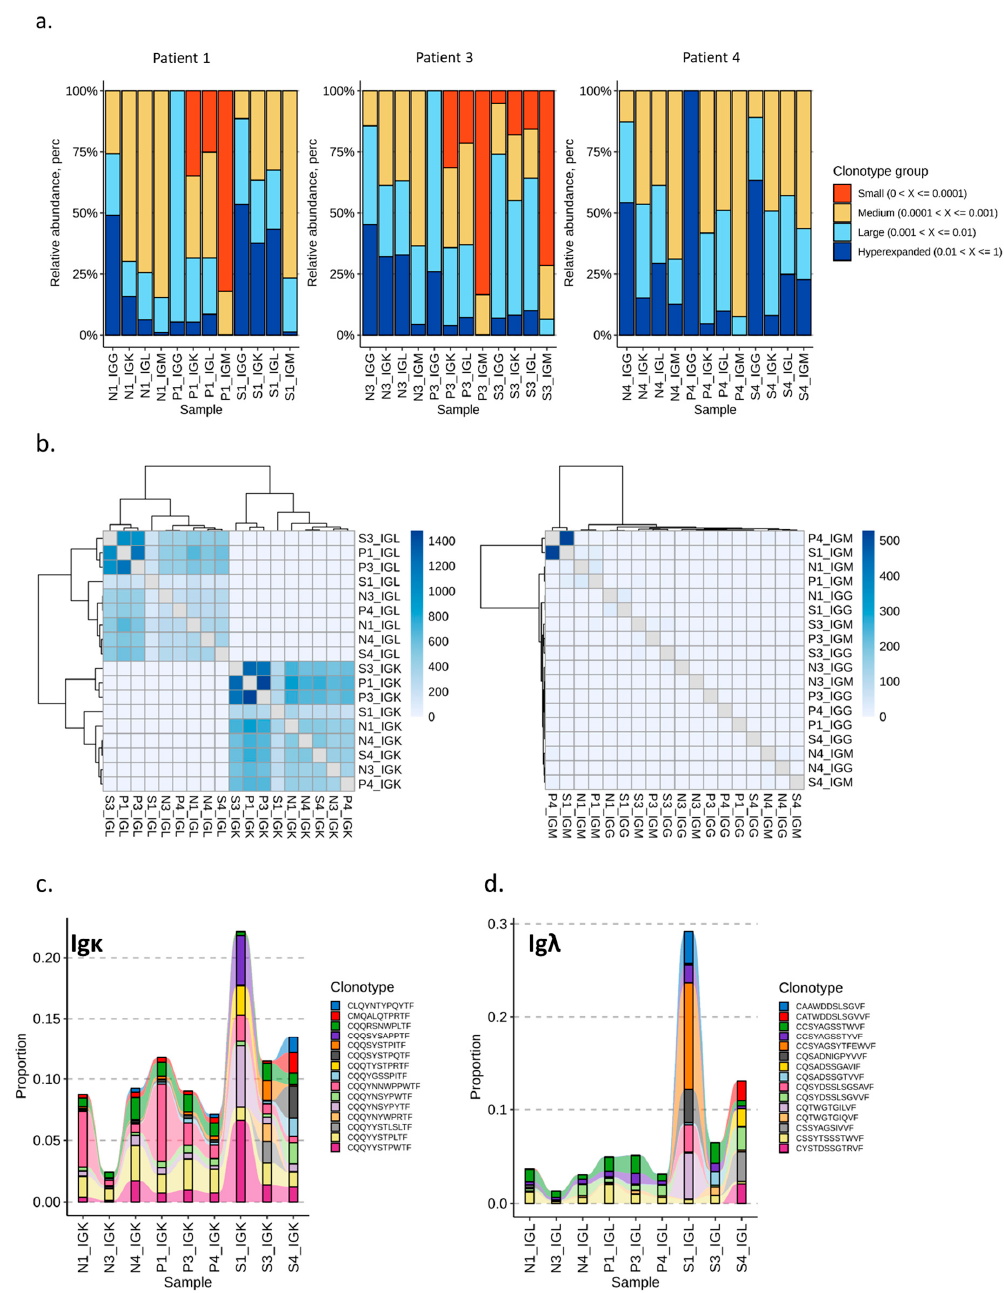
Figure 6. V(D)J sequencing and analysis. B cells were purified from N-SN (N), peripheral blood (P), and SN (S) from three patients (patient 1–N1, P1, S1–PSA: 9.9, Gleason Score: 7a, Stage: T3a, Age: 71; patient 3–N3, P3, S3- PSA: 8.6, Gleason Score: 9, Stage: T3a, Age: 78; patient 4–N4, P4, S4–PSA: 8.6, Gleason Score: 6, Stage: T2, Age: 67). Total RNA was isolated and subsequently used for cDNA synthesis and library preparation of CDR3 region of V(D)J segments using SMARTer Human BCR IgG IgM H/K/L Profiling Kit (Takara). The PCR product was sequenced (MiSeq Illumina platform) and analyzed using the Immunarch package. ( a ) Relative abundance for clonotypes identified in N-SN, peripheral blood, and SN. ( b ) Heatmap representing hierarchical clustering according to the number of public clonotypes across light (left) and heavy (right) chains of IgG and IgM isotypes. ( c ) Visualization of tracking the top 5 Ig κ clonotypes identified in SN across all samples. ( d ) Visualization of tracking the top 5 Ig λ clonotypes identified in SN across all